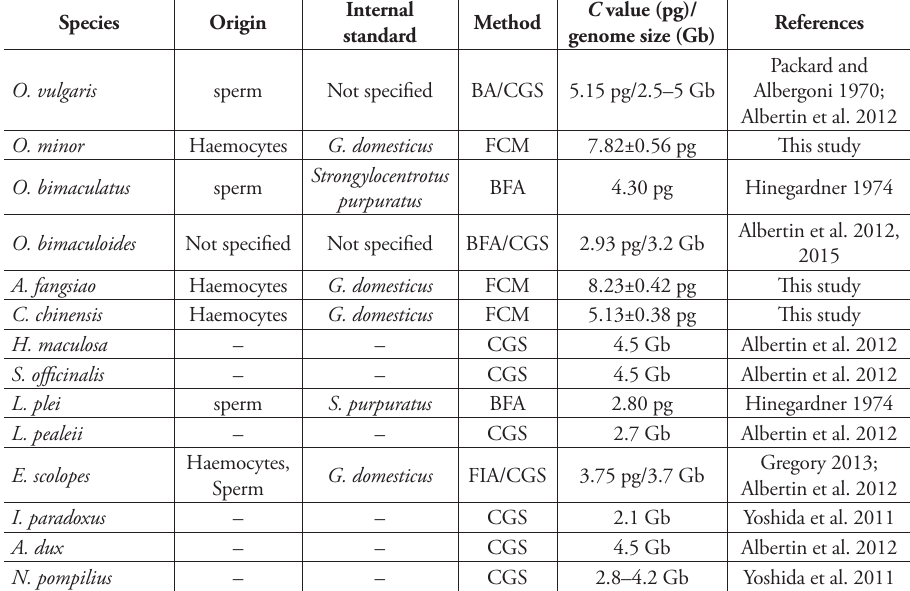
Table 1. The published information of cephalopod genome size. BA : Biochemical Analysis, FCM : Flow Cytometry, BFA : Bulk Fluorometric Assay, CGS : Complete Genome Sequencing, FIA : Feulgen Image Analysis